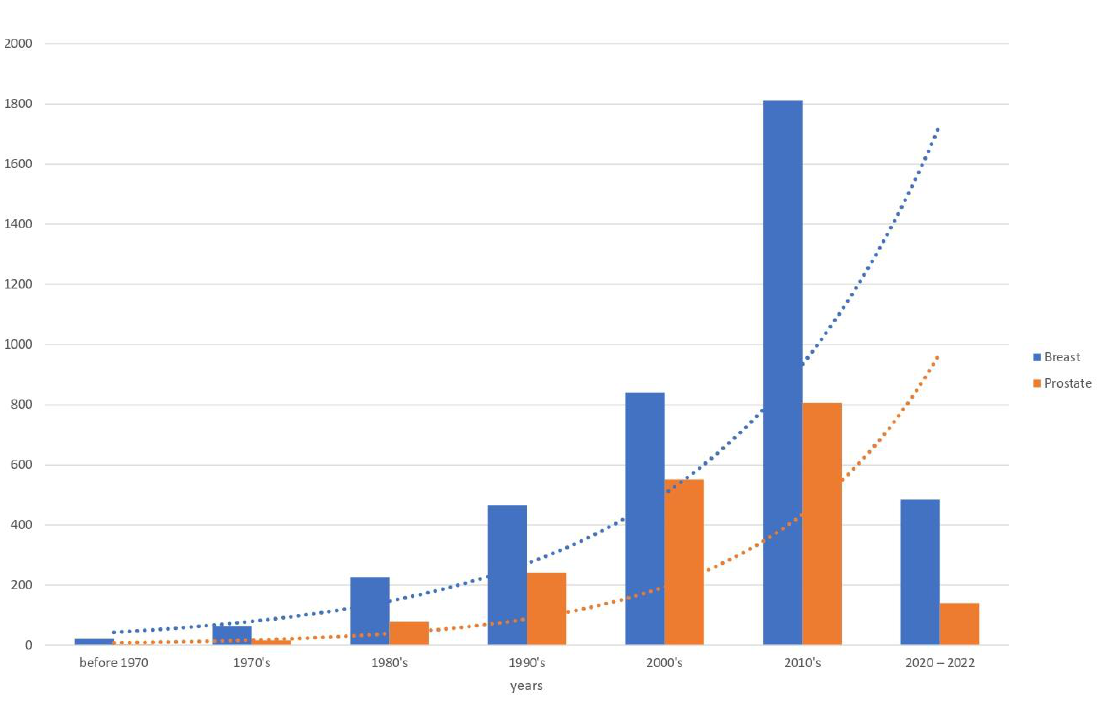
Figure 1. Evolution of the number of published studies based on the tumoral stroma in breast and prostate carcinomas. Source: PubMed.